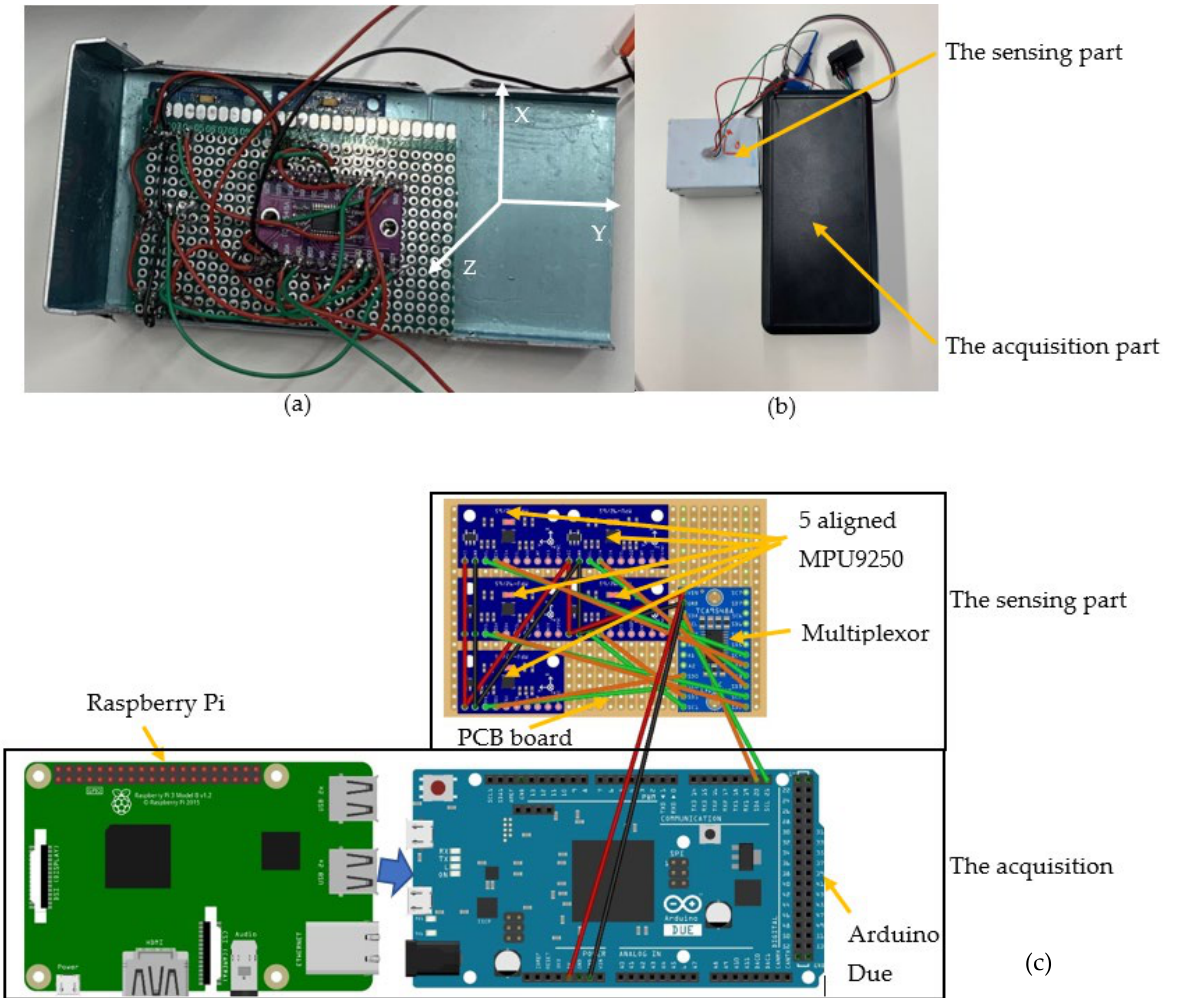
Figure 1. LARA elements: ( a ) the adjustments and wire connections of the sensing part, ( b ) the sensing and acquisition part, and ( c ) LARA in detail.